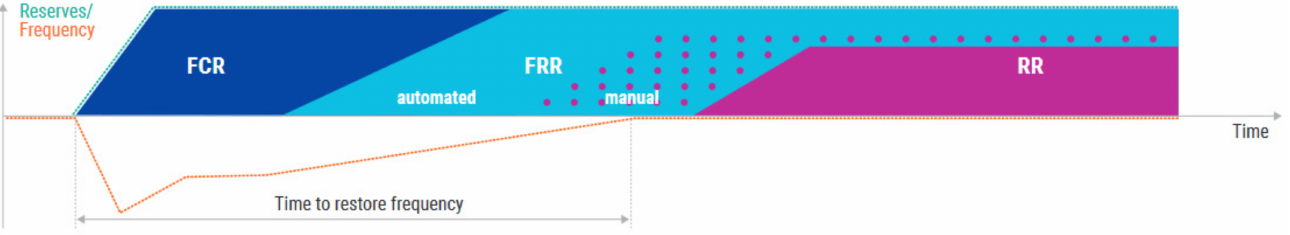
Figure 2. The Balancing Reserve Market